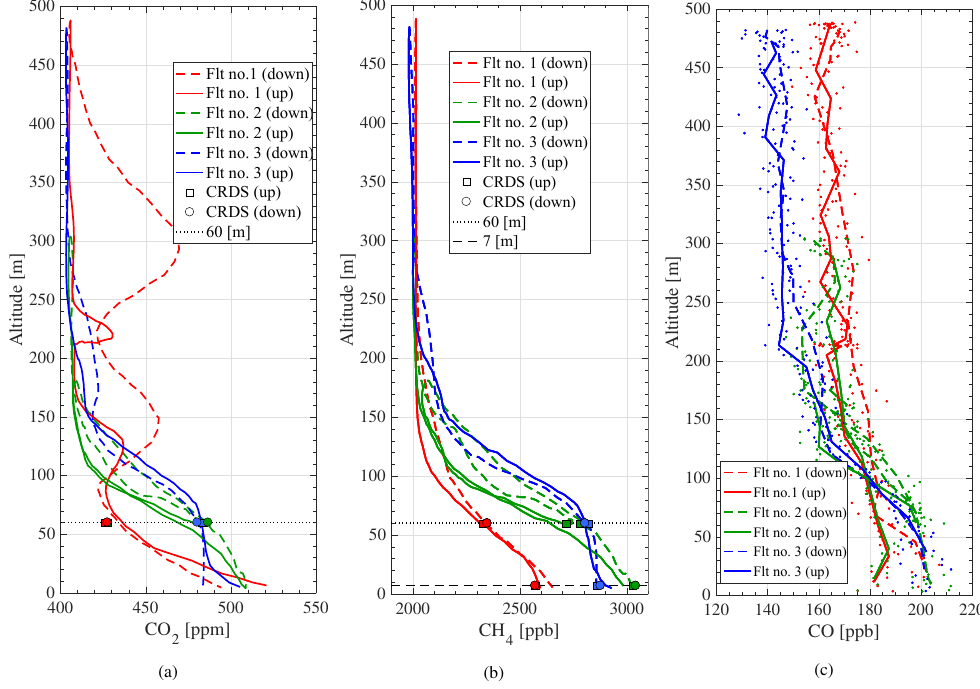
Figure 10. Vertical profiles of (a) CO 2 , (b) CH 4 , and (c) CO for flight nos. 1–3. Panels (a) and (b) include a dotted line indicating 60m and shows measured trace gas mole fractions from the Lutjewad atmospheric station at this height. Panel (b) also includes a dotted line to indicate 7m height and the corresponding CH 4 values obtained from the atmospheric station at this height. The square points represent the mole fractions measured at the time of the UAV ascent, and the circular points represent the mole fractions measured during the UAV descent. The color of the markers represents its respective flight. The CO mole fractions shown in panel (c) have been averaged by every fifth data point. The ambient temperature and relative humidity are not shown due to the sensors only being placed inside the box, as discussed in Sect.